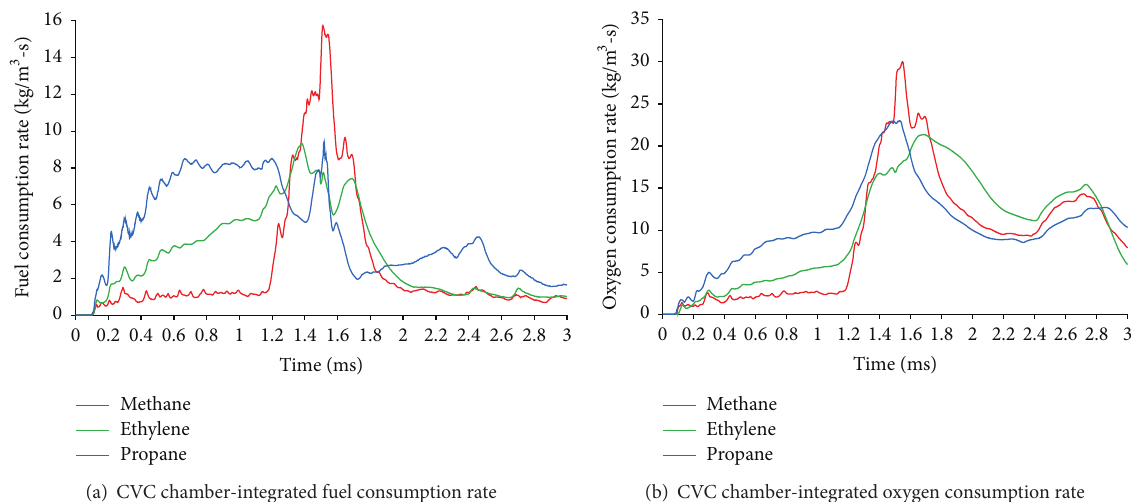
Figure 9: Comparison of fuel and oxygen reaction rates in the CVC chamber for three fuel mixtures, integrated over the chamber volume.